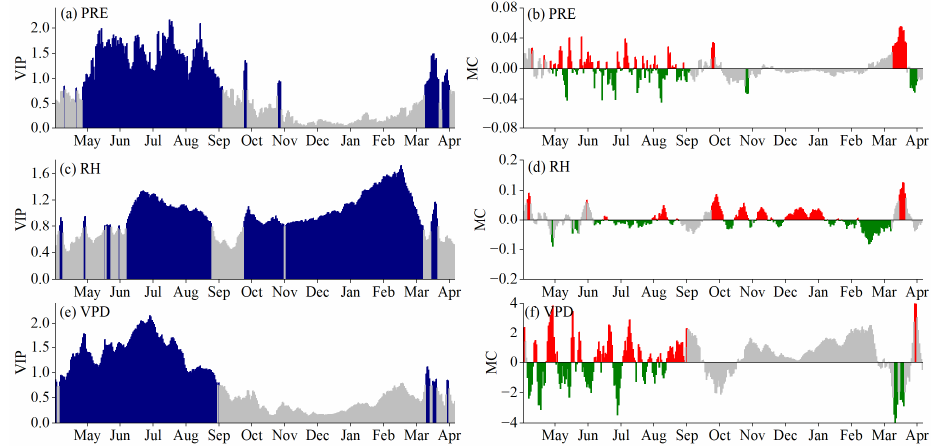
Figure 3. Results of partial least squares (PLS) regression correlating the start of the growing season (SOS) from 1985–2018 with 31-day running means of climatic factors. ( a , b ) Daily precipitation (PRE), ( c , d ) relative humidity (RH) and ( e , f ) vapor pressure deficit (VPD) from the previous May to April of the year.